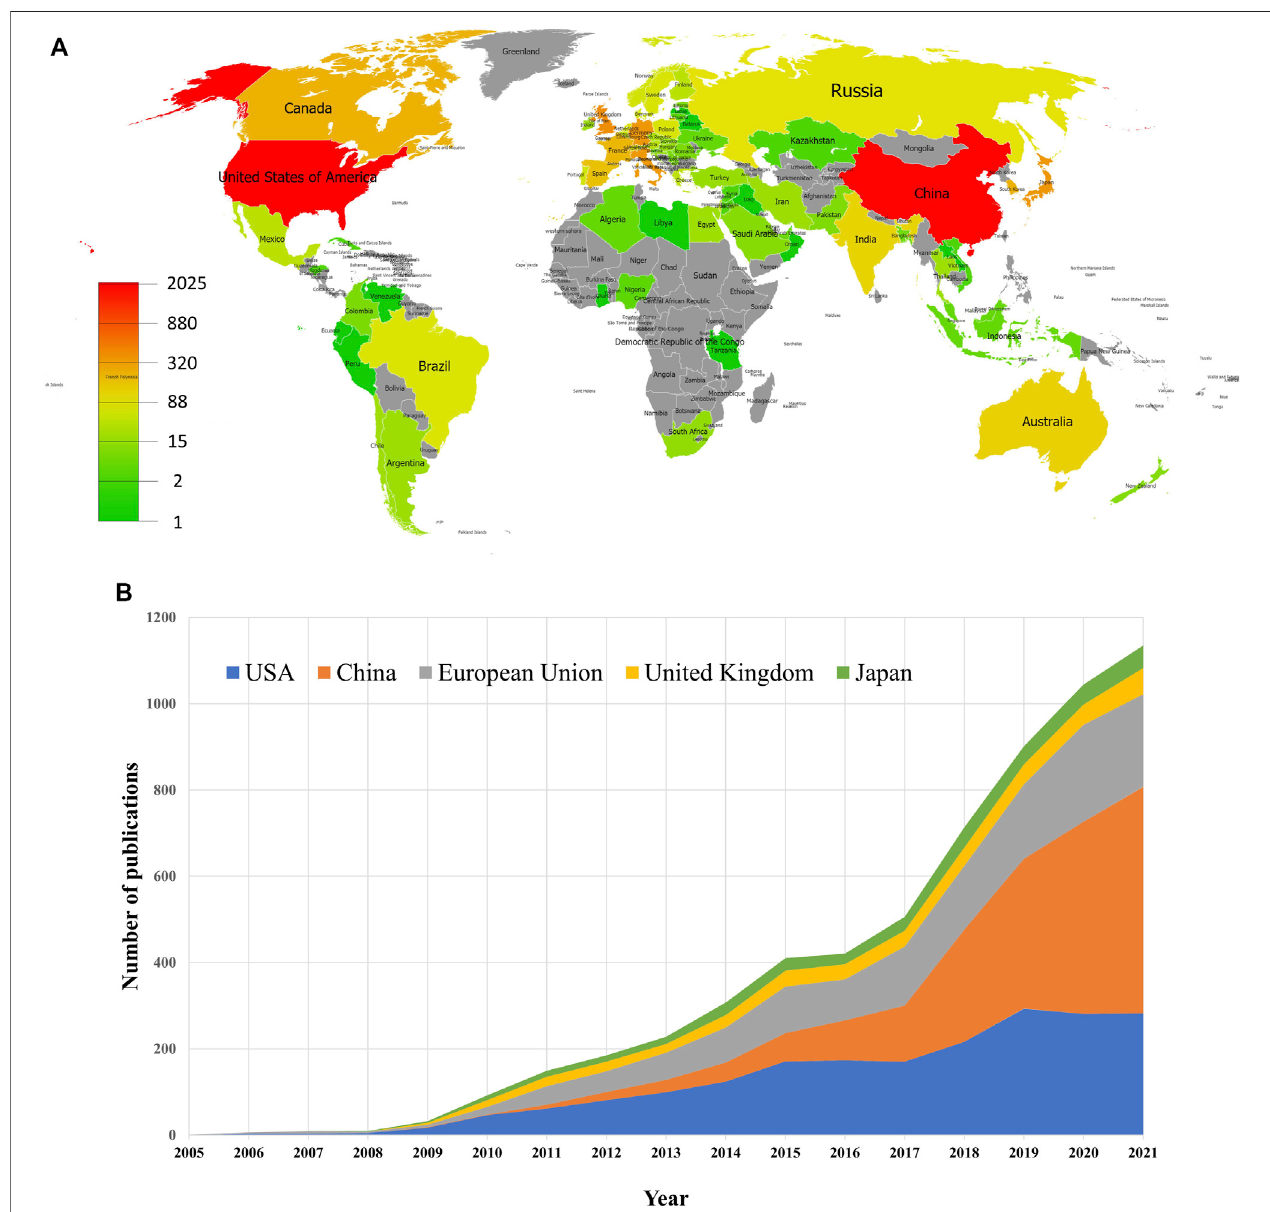
FIGURE 3 | Geographical distribution of publications on mitophagy. (A) Geographical distribution map of publications on mitophagy. (B) Trends of the annual publications of mitophagy in the United States, China, European Union, United Kingdom, and Japan.